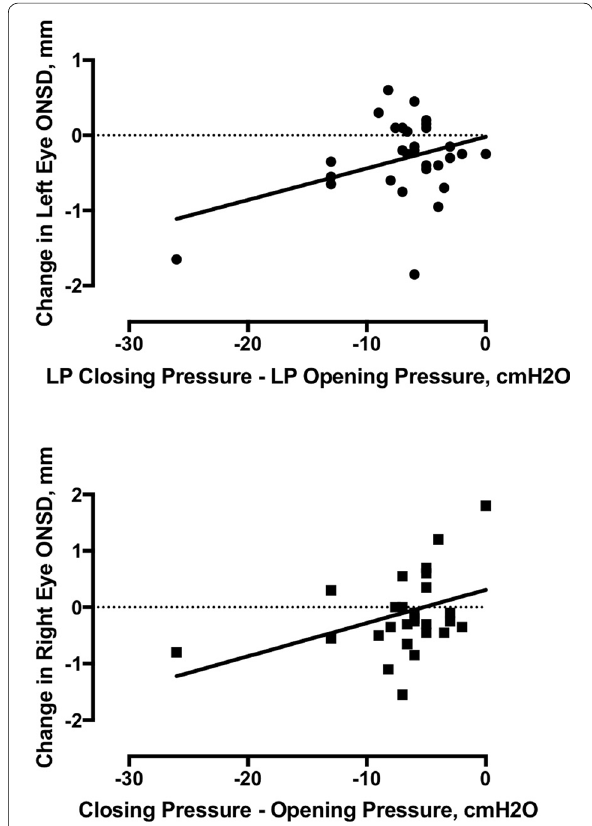
Fig. 2 Linear regression analysis of change in between opening and closing pressures (in cmH 2 ) compared against the change in optic nerve sheath diameter (mm), averaged between transverse and sagittal plan measurements, for the left and right eyes, respectively